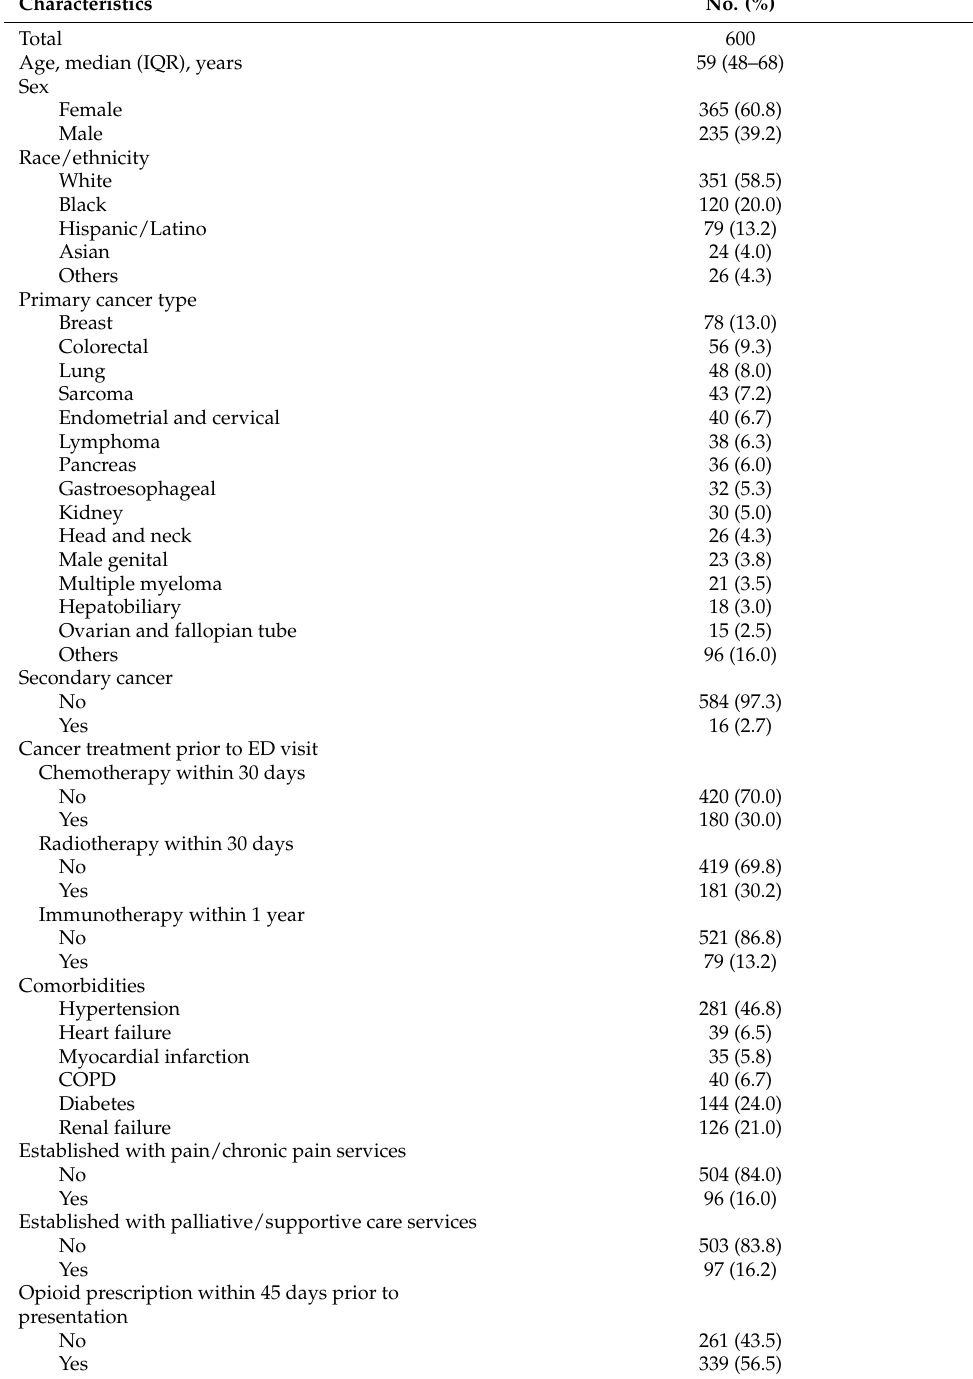
Table 1. Characteristics of cancer patients placed in an emergency department observation unit with